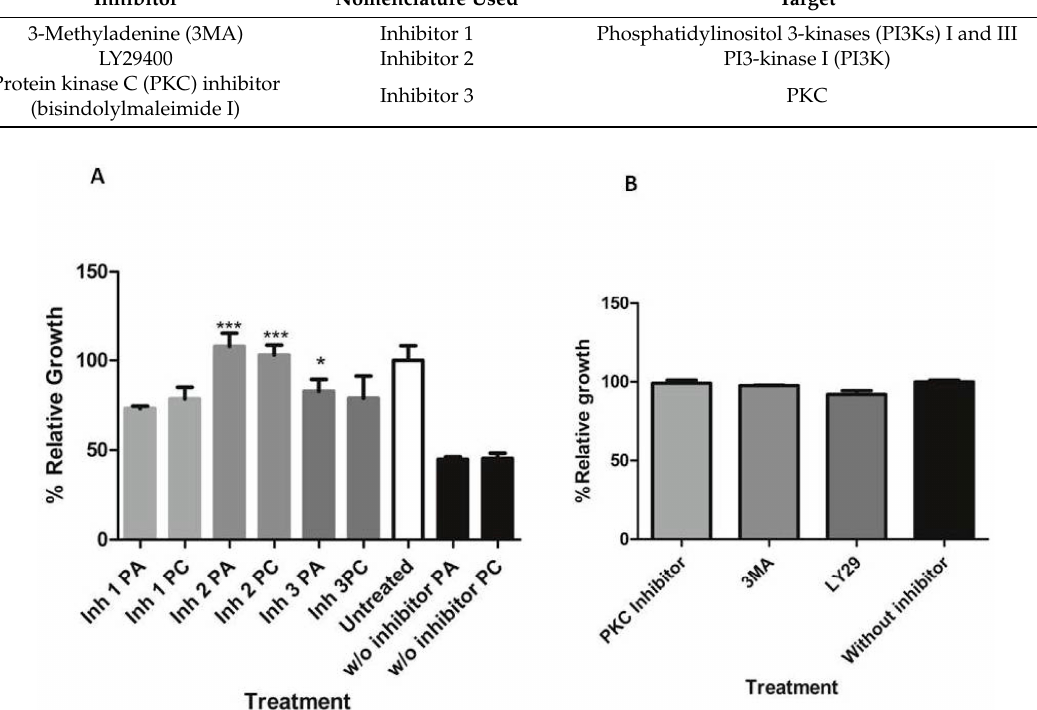
Table 3. Inositol triphosphate (IP3)-related signal transduction pathway inhibitors. Inhibitor